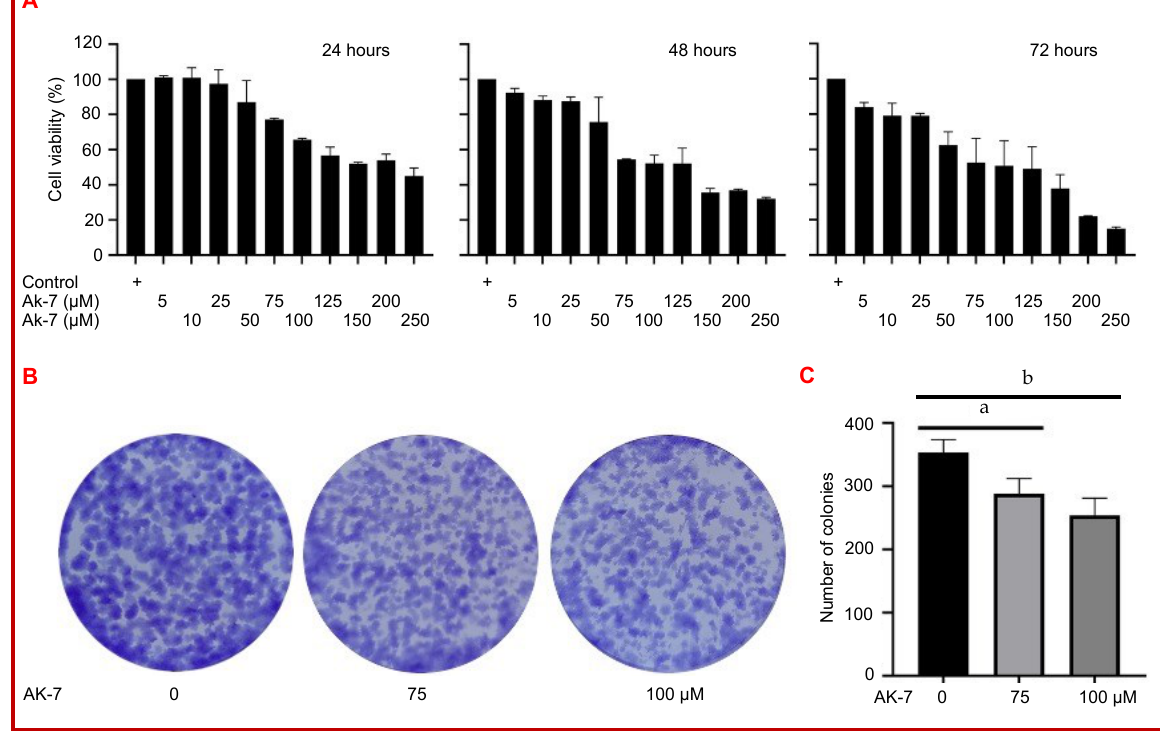
Figure 1: AK-7 reduced the survival and colony formation of glioblastoma multiforme cells. Dose- (5, 10, 25, 50, 75, 100, 125, 150, 200, and 250 µM) and time- (24, 48, 72 hours) dependent effect of AK-7 on the U87 human glioblastoma multiforme cell line (A). Colony formation assay was performed to analyze the colony forming capacity of U87 cells which were treated with different concentrations (75 and 100 μ M) of AK-7 ( a p<0.05; b p<0.01)